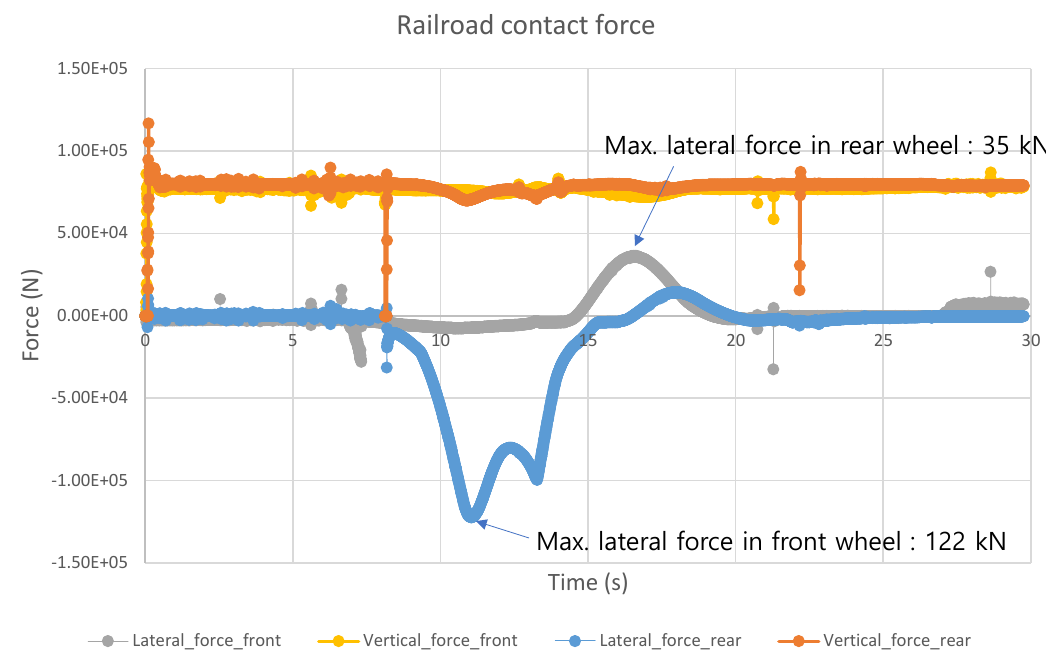
Figure 12. Contact force–time history variable.